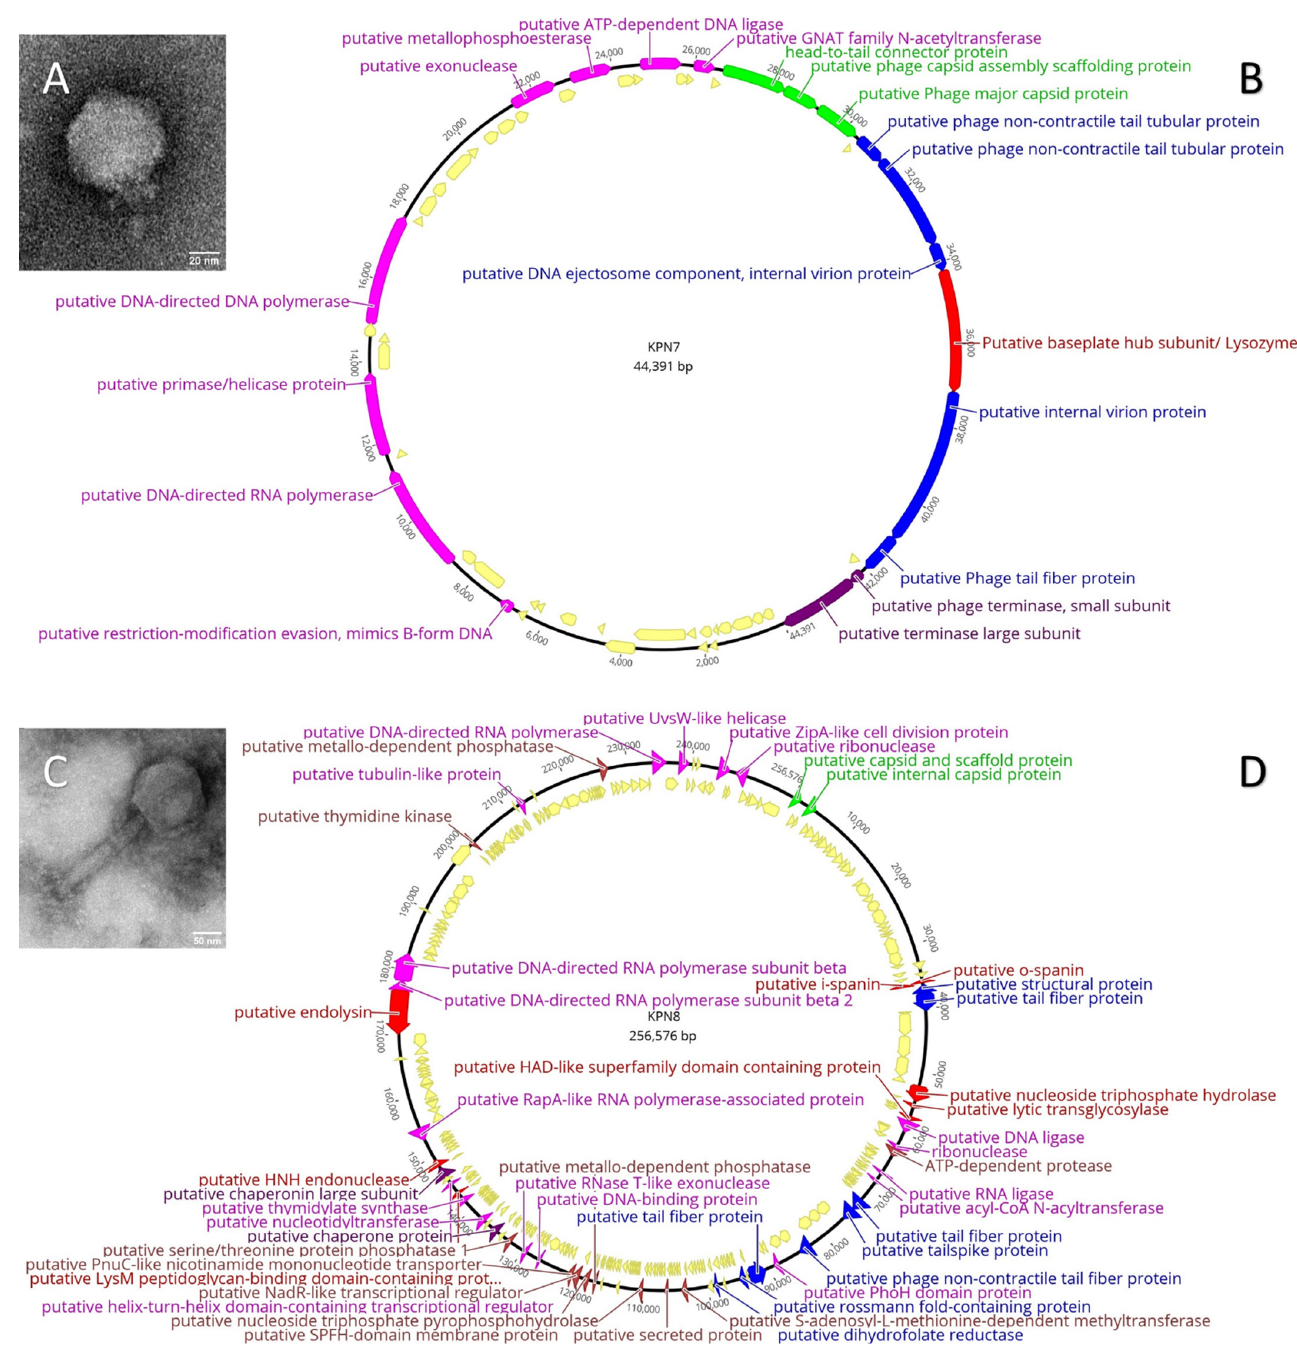
Figure 1. Characterisation of bacteriophages KPN7 and KPN8. ( A , C ): Electron micrographs of bacteriophage KPN7 ( A ) (Capsid dimensions: diameter = 62.3 ± 1 nm, Tail length = 15.3 ± 3 nm, Tail width = 15.6 ± 1 nm) showing a typical Podovirus morphology and bacteriophage KPN8 ( C ) (Capsid dimensions: diameter = 130.2 ± 3 nm, Tail length = 196.1 ± 4 nm, Tail width = 53.7 ± 11 nm) shown with a typical Myovirus morphology. ( B , D ): Genomic representation of bacteriophages KPN7 ( B ) and KPN8 ( D ), shown in circular form for ease of visualisation. Putative functions of genes are denoted by purple (putative packaging protein), green (putative head or capsid structural protein), blue (putative tail structural genes), red (putative lysin proteins), brown (putative metabolic proteins), and pink (putative DNA manipulation proteins). Hypothetical proteins are shown in yellow.